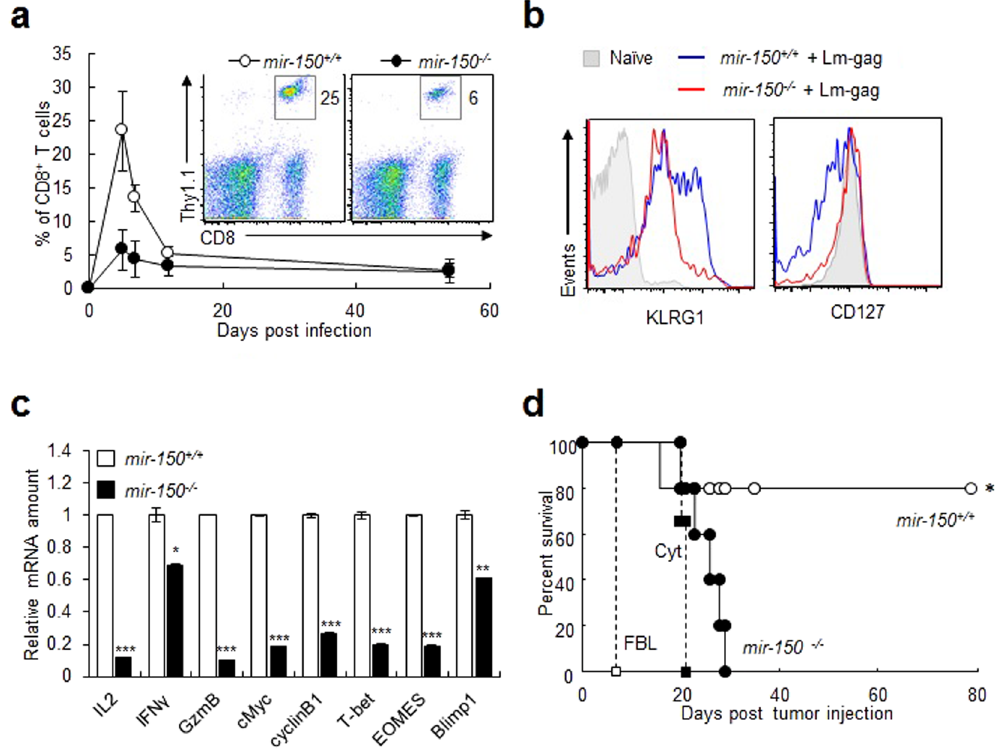
Figure 1. miR-150 deficiency decreases responsiveness to antigenic stimulation and antitumor activity of CD8 + T cells in vivo . ( a ) Kinetics of mir-150 + / + and mir-150 − / − CD8 + T cells after antigenic stimulation in vivo . Thy1.1:TCR gag : mir-150 + / + or Thy1.1:TCR gag : mir-150 − / − CD8 + T cells were transferred to Thy1.2 C57/BL6 mice. The mice were injected with Lm-gag intraperitoneally. The transferred CD8 + T cells were analyzed using blood samples at 0, 5, 7, 12, and 54 d after the transfer. (b) Expression of surface markers in mir-150 − / − and mir- 150 + / + CD8 + T cells at 5 d after transfer and Lm-gag injection. (c) Relative mRNA amount of activation- induced molecules in mir-150 − / − and mir-150 + / + CD8 + T cells after stimulation for 5 h. (d) Antitumor activity of mir-150 − / − and mir-150 + / + CD8 + T cells in vivo . Mice were injected intra-peritoneally with FBL-gag cell. At 5 d after FBL injection, the mice were received cytoxan (Cyt) and 6 h later transferred mir-150 + / + or mir-150 − / − CD8 + T cells. FBL; FBL injection, Cyt; FBL and Cyt injection, mir-150 − / − or mir-150 + / + ; FBL, cyt and CD8 + T cell injection. * P < 0.05, ** P < 0.01, *** P < 0.001. Data are means ± SEM of duplicate triplicate samples from a single experiment and are representative of two independent